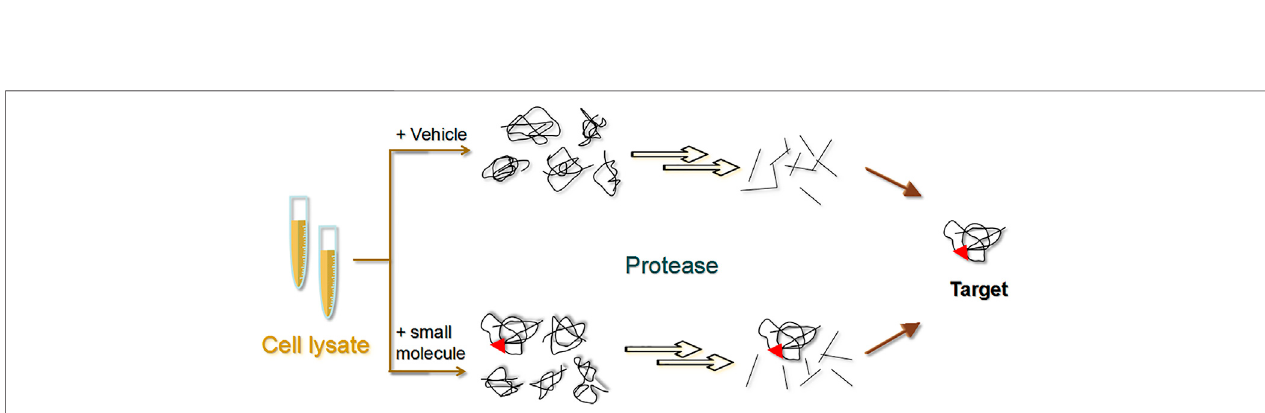
FIGURE 7 | Flow diagram of the combined activity-based protein pro fi ling (ABPP) and stable isotope labeling by amino acids in cell culture (SILAC) strategies. Firstly,itutilizesasetofaminoacidisotopemarkersfortwocellpopulationstobecultured.Theprobeisaddedtotheheavygroupandthelightgroupisusedasacontrol group. The labelled proteins are analyzed and identi fi ed by MS against normal proteins after a period of time.